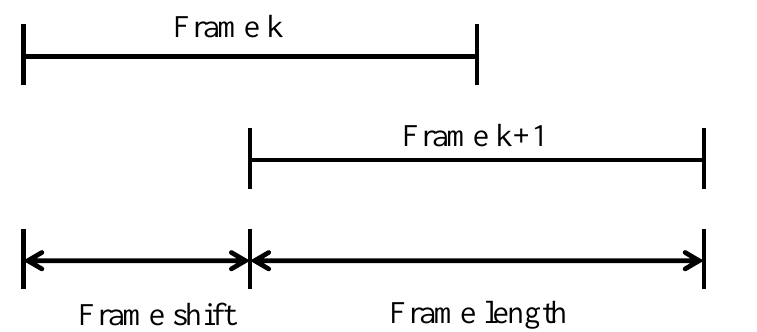
Figure 2. Relationship between frame shift and frame length.